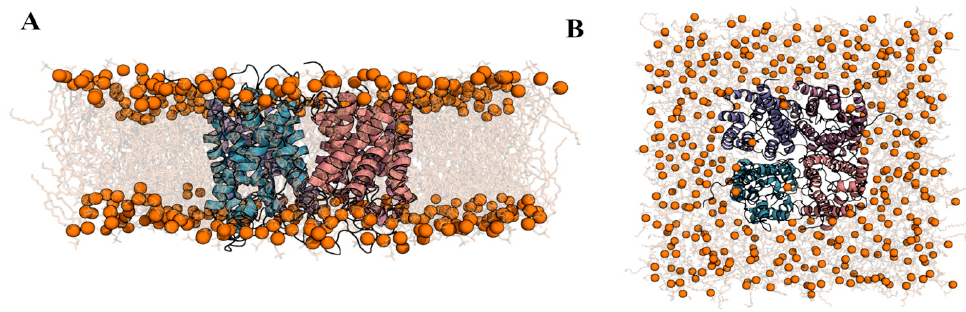
Figure 4. Structural representation of the initial conformation of the homotetramer of AQP3 fully embedded in a model POPC membrane. ( A , B ) represent, respectively, the side and top view of the simulation system. Each monomer of the AQP3 protein is colored differently as cartoon, while the phosphorous atoms of the POPC lipids are represented as orange spheres, attached to the lipidic tails, and which are represented with grey sticks. Water molecules are not explicitly represented in the figure.